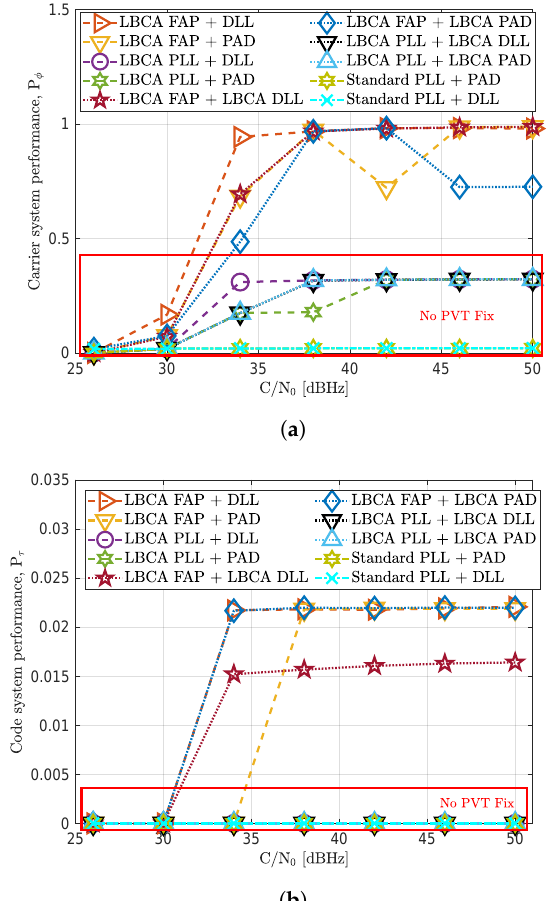
Figure 11. System performance evaluation in dynamic scenario. ( a ) Carrier system performance. ( b ) Code system